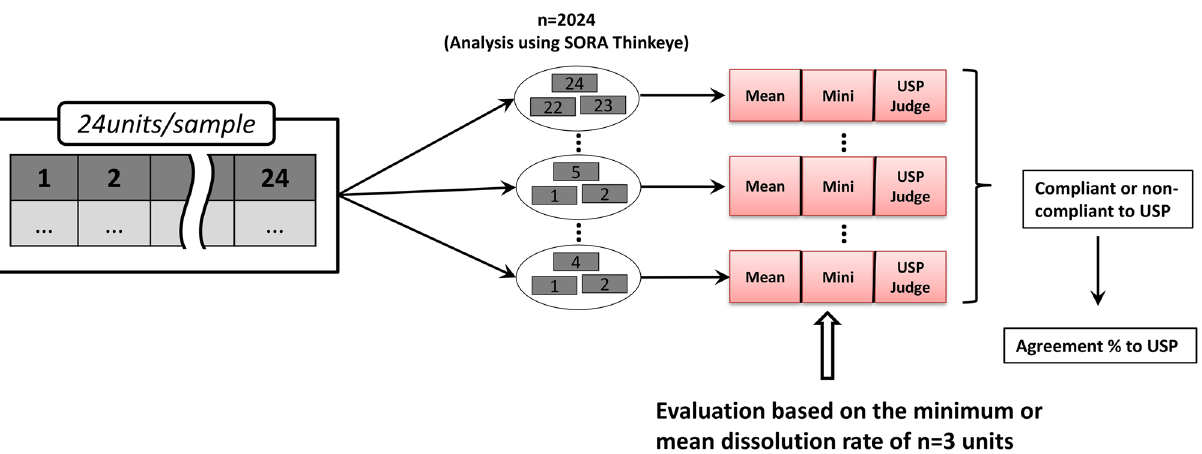
Figure 2. Schematic illustration of the combination of average dissolution rate and minimum dissolution rate as the compliance (mean) and minimum dissolution rates were determined. These were used as independent variables and the USP result was used as a dependent variable to create a form of decision tree, known as a style tree (Figs. 2, 3). Extraction was carried out using Microsoft Excel and the process was repeated for each of the n = 21 samples. The style tree was generated using Thinkeye software (SORA Universal Archives Inc.), which provided a dendrogram (Fig. 3) based on the Iterative Dichotomiser 3 (ID3) algorithm, using a parameter called informa- tion entropy to construct a decision tree by finding the question that best separates two or more groups 26,27 . This approach was used to examine the relationship between the dissolution rate of sets of n = 3 units and the result of USP evaluation of dissolution. In other words, it is a method of deriving the criterion that can best separate compliant and non-compliant samples. In cases where the mean and minimum values are the same but the USP judgement is different, that event was designated as “no conclusion”. Validation. To validate the developed methodology and criteria, they were next applied to 17 samples of cimetidine. The dissolution test of cimetidine was carried out according to USP 23 . The Q value for cimetidine is